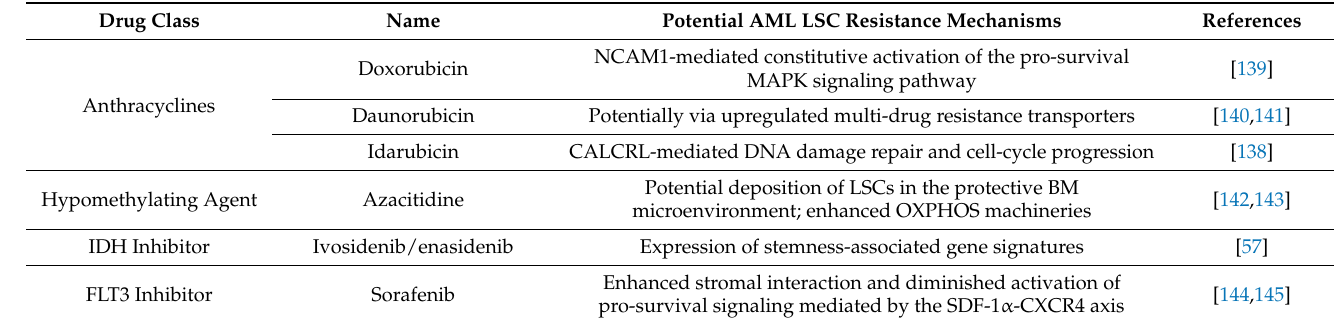
Table 2. Exemplary LSC Resistance Mechanisms to Clinically Approved AML